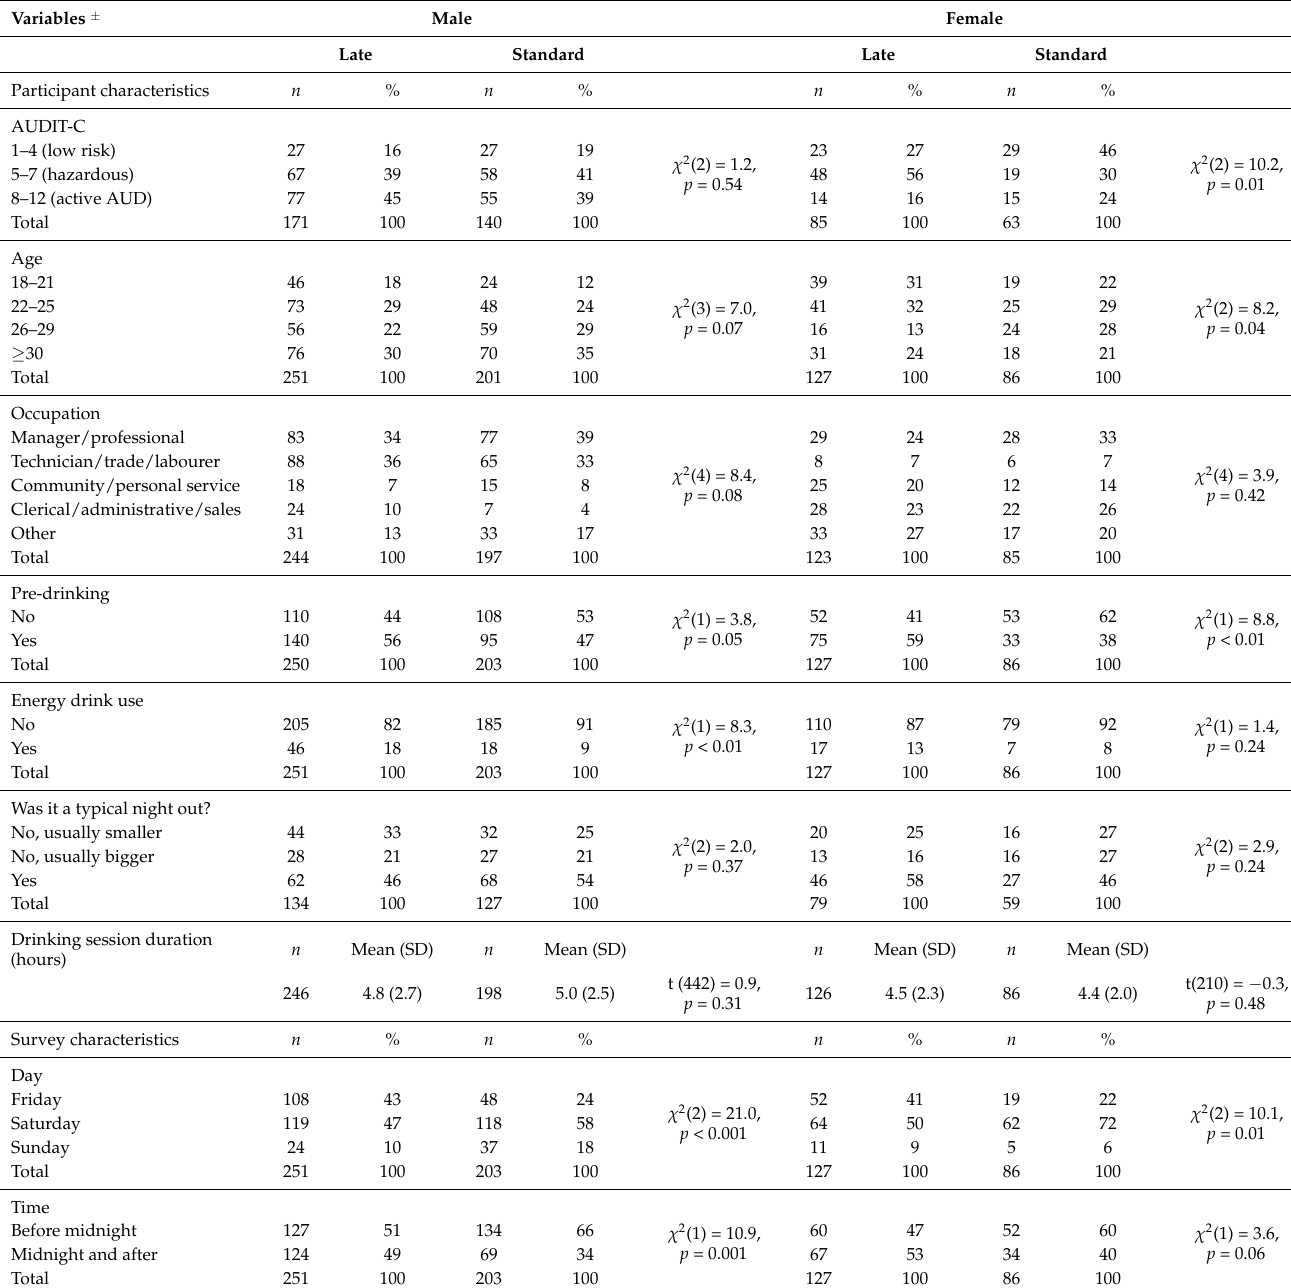
Table 1. Gender-specific descriptive statistics and bivariate analyses for participant and survey characteristics by participants’ preferred bar’s closing